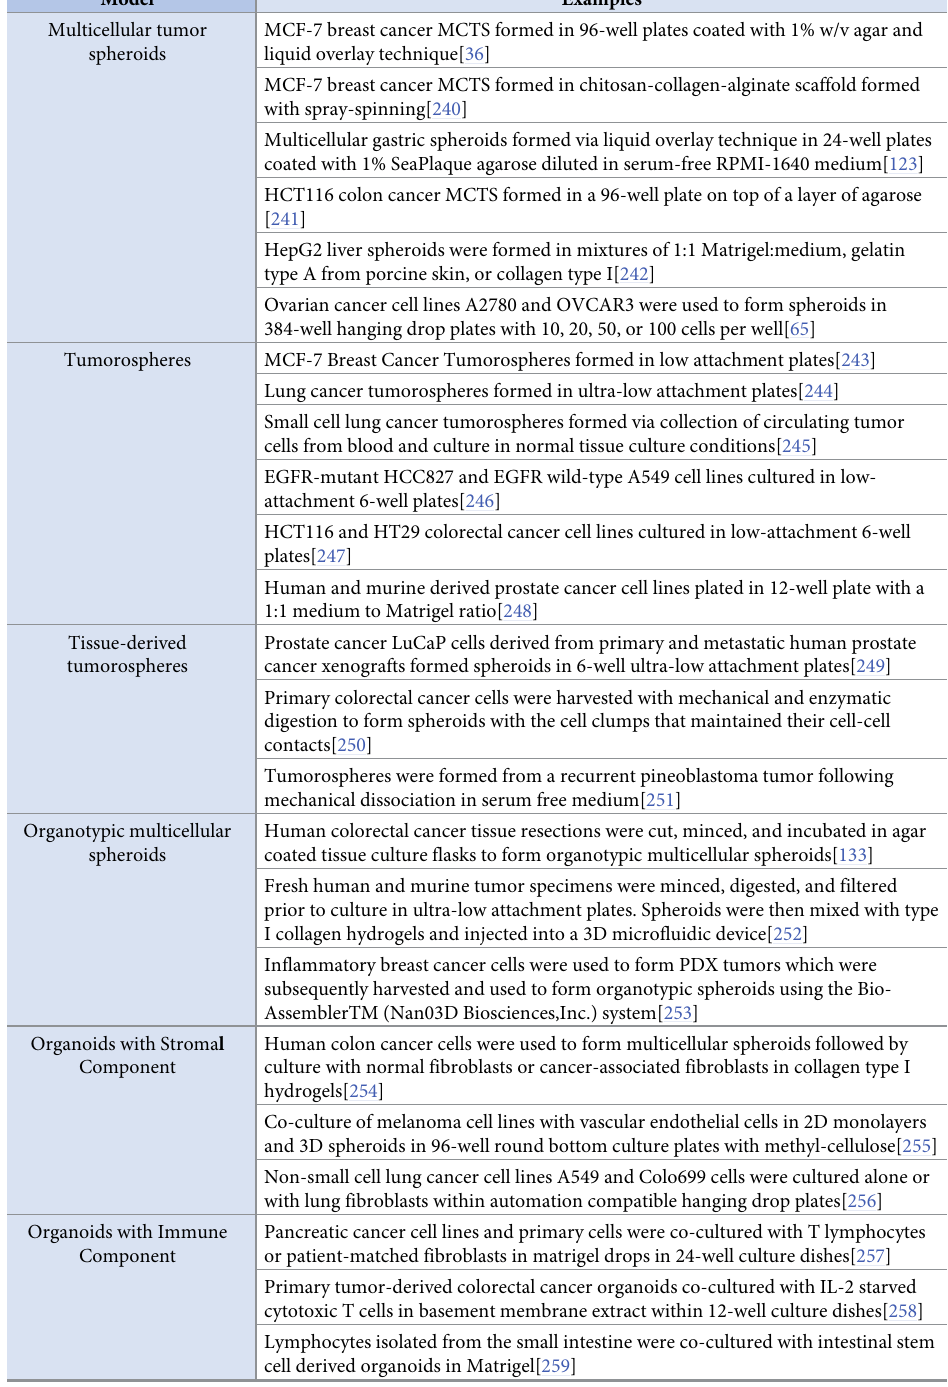
Table 2. Examples of 3-dimensional cancer bioengineering models that emphasize cell-cell